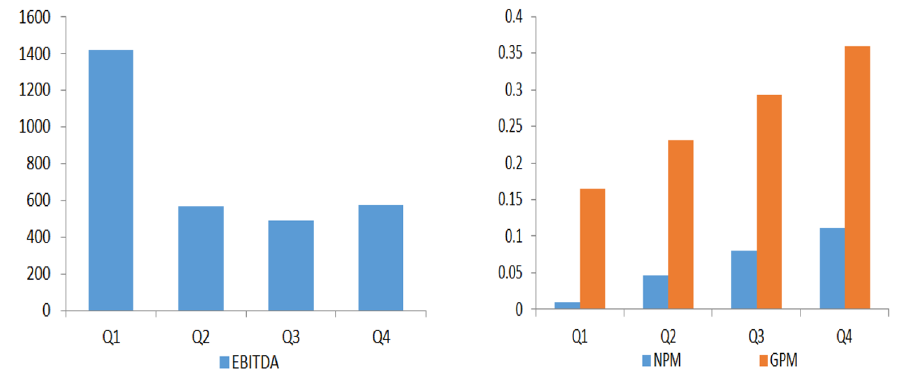
Figure 2. The contribution of IC in firm profitability